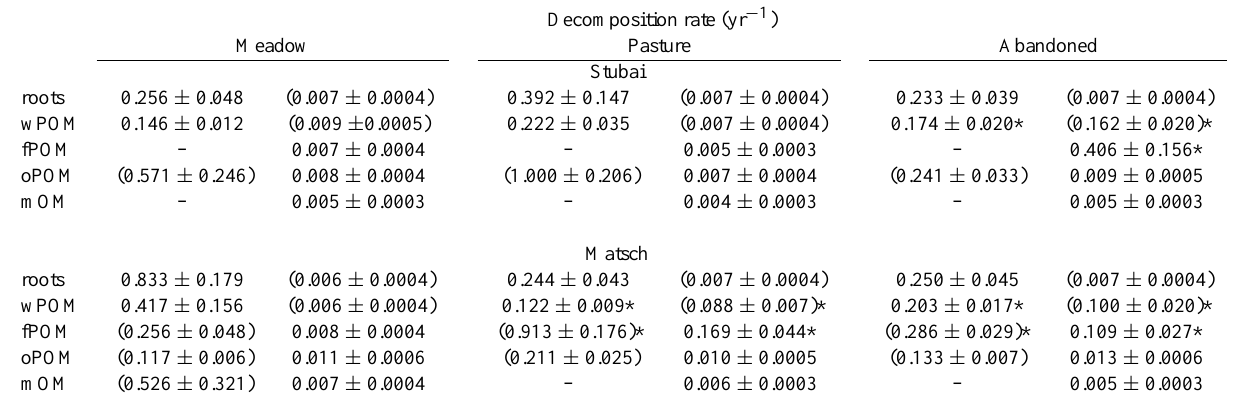
Table 4. Decomposition k rates of roots and SOM fractions of meadow, pasture and abandoned grassland at the Stubai and Matsch site. k was calculated based on the radiocarbon signature using steady-state and nonsteady-state models (*). Both models produce two solutions yielding in the measured radiocarbon content and C stock in 2008. Implausible solutions are put in parenthesis. For the definition of implausible solutions see